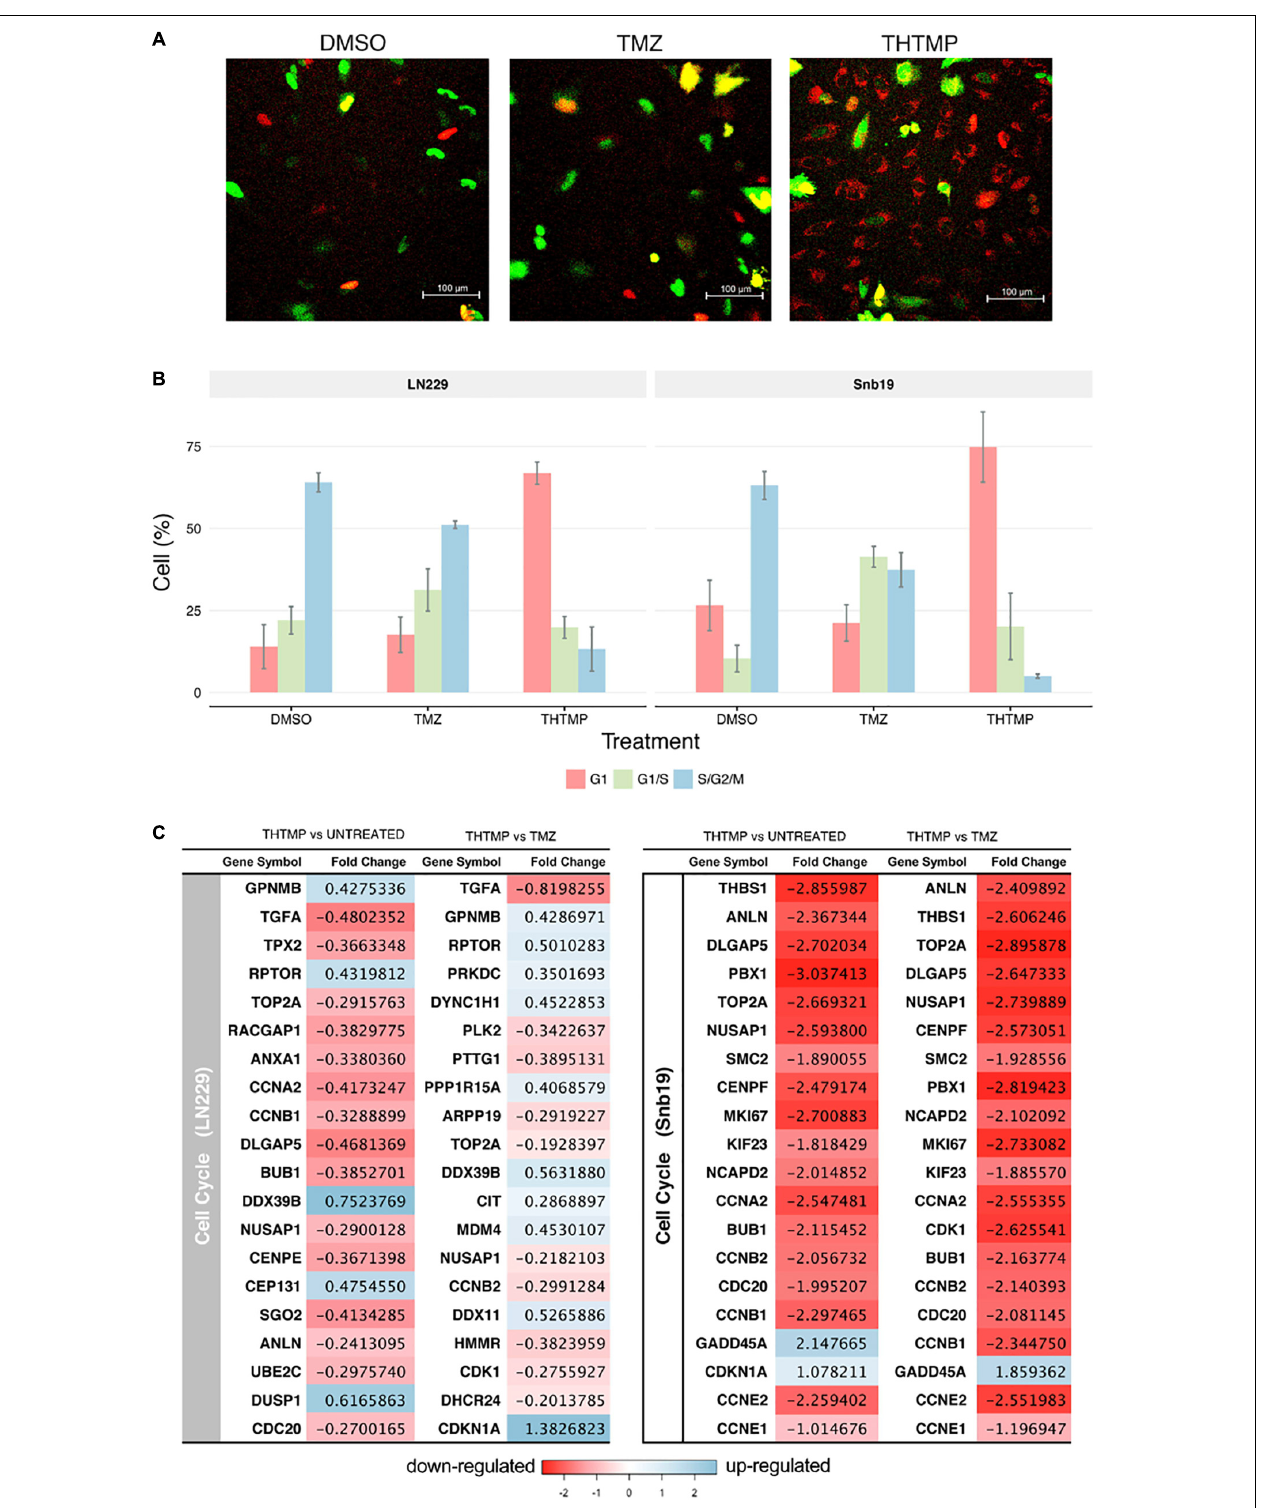
FIGURE 5 | Cell cycle analysis using FUCCI and RNA-seq. (A) Demonstrated images of cell which were dyed with FUCCI in different conditions (DMSO, TMZ, and THTMP). Red cells corresponding to the cells in G1, yellow cells corresponding to the cells in G1/S phase and the green cells corresponding to the cells in S/G2/M phase (B) Percentage of total cell in different phases when they were treated with THTMP and TMZ. (C) The top 20 DEGs which are involved in the cell cycle on LN229 and Snb19. The DEGs were color coded, with the colors corresponding to the up- and down- expressed.